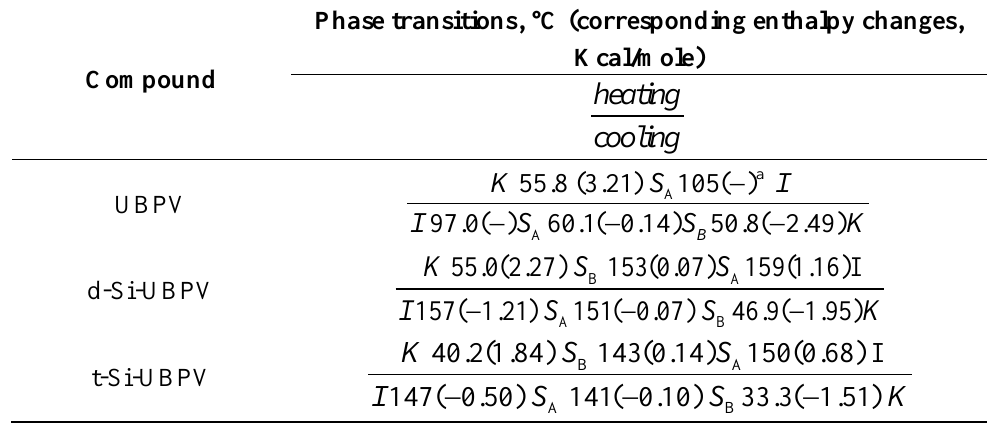
Table 1. Thermal transitions of compounds UBPV, d-Si-UBPV and